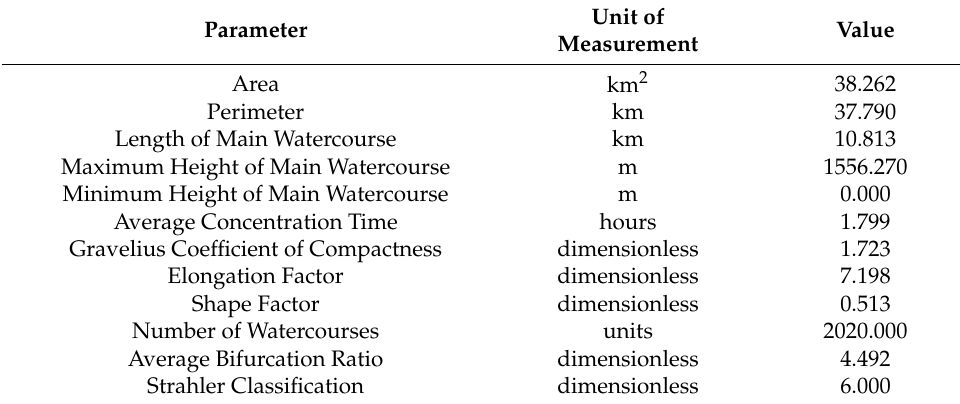
Table 1. Parameters calculated or extracted from ArcGIS.